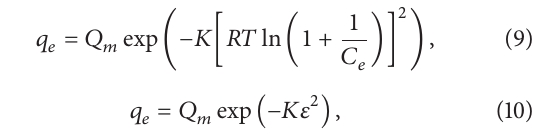
coefficients ( 𝑅 2 ), 𝐾 𝐹 , and 𝑛 were found to be 0.9682, 7.932,